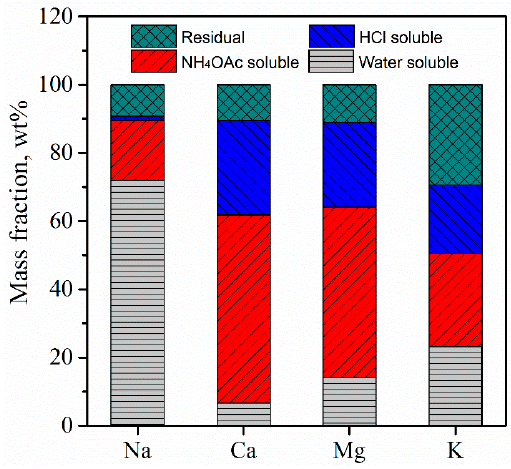
Figure 1. The occurrence form of alkali and alkaline earth metals (AAEM) in Zhundong coal.